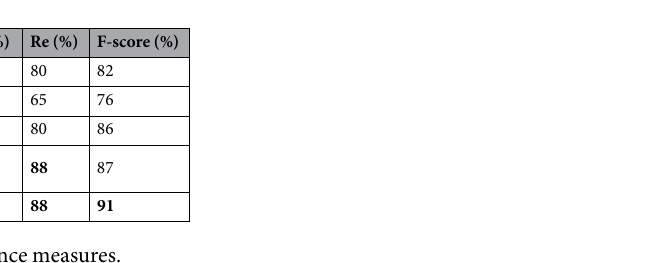
Table 8. Comparison of performance